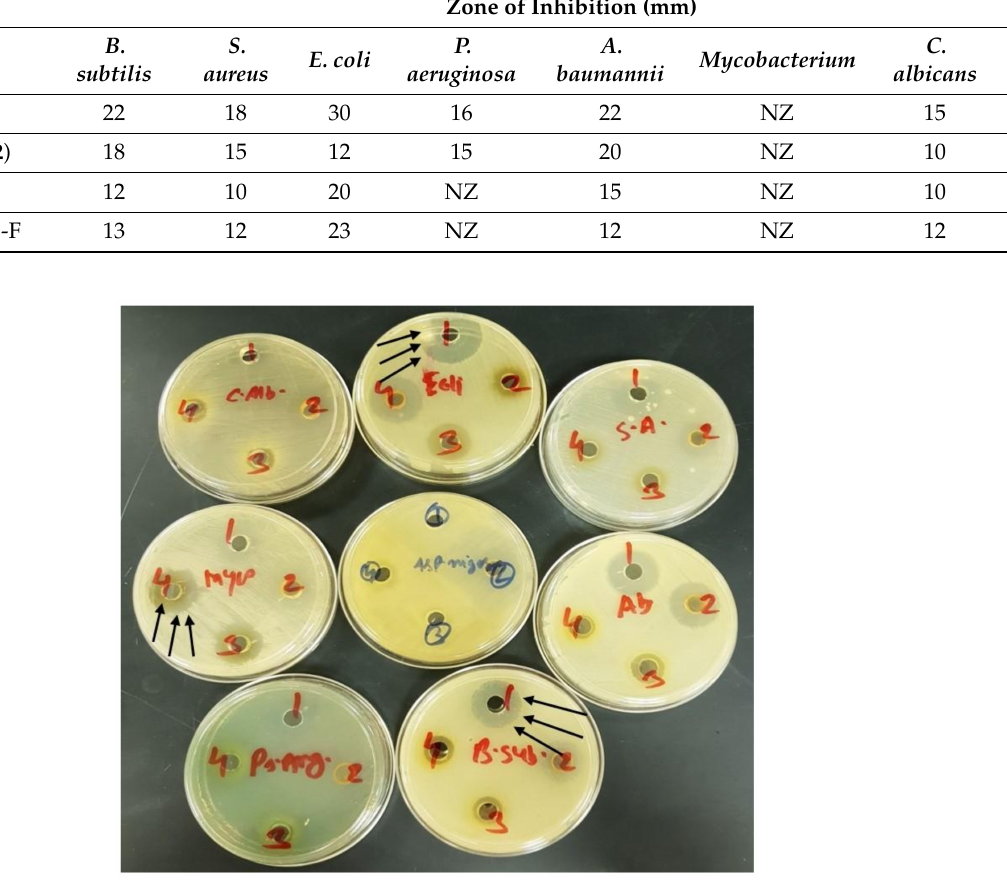
Figure 8. The images show the antimicrobial activities against S. aureus , E. coli, B. subtilis, P. aeruginosa, A. baumannii, Asp. niger, Mycobacterium, and C. albicans. The compounds represent (1) isatin pure drug, (2) compound ( 2 ) pure drug, (3) isatin loaded lipid-based formulation, and (4) compound ( 2 ) loaded lipid-based formulation. The arrow indicates the maximum zone of